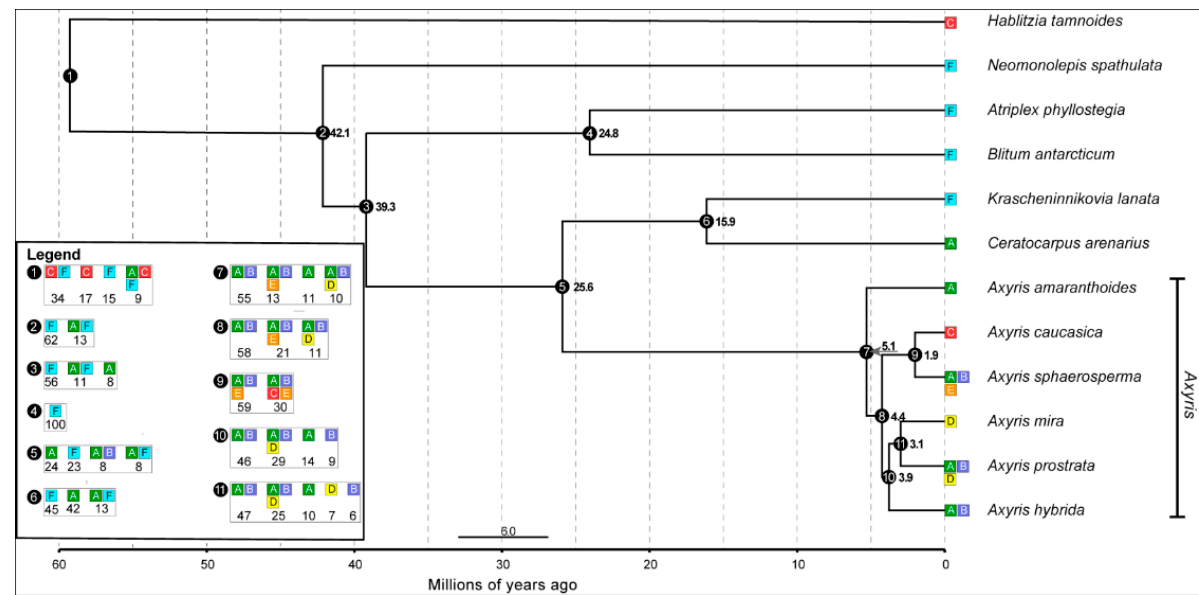
Figure 7. The time-calibrated tree of six Axyris taxa, as generated in BEAST2 allowing one accession per species. The ancestral area analysis was conducted by means of BioGeoBEARS in R v.3.3.2. Coding of biogeographical areas: A: Southern Siberia, Mongolia, and NW China; B: Tian-Shan and Pamir; C: Greater Caucasus; D: Himalayas/Tibet; E: Eastern Siberia (Sakha Rep.); F: North America.